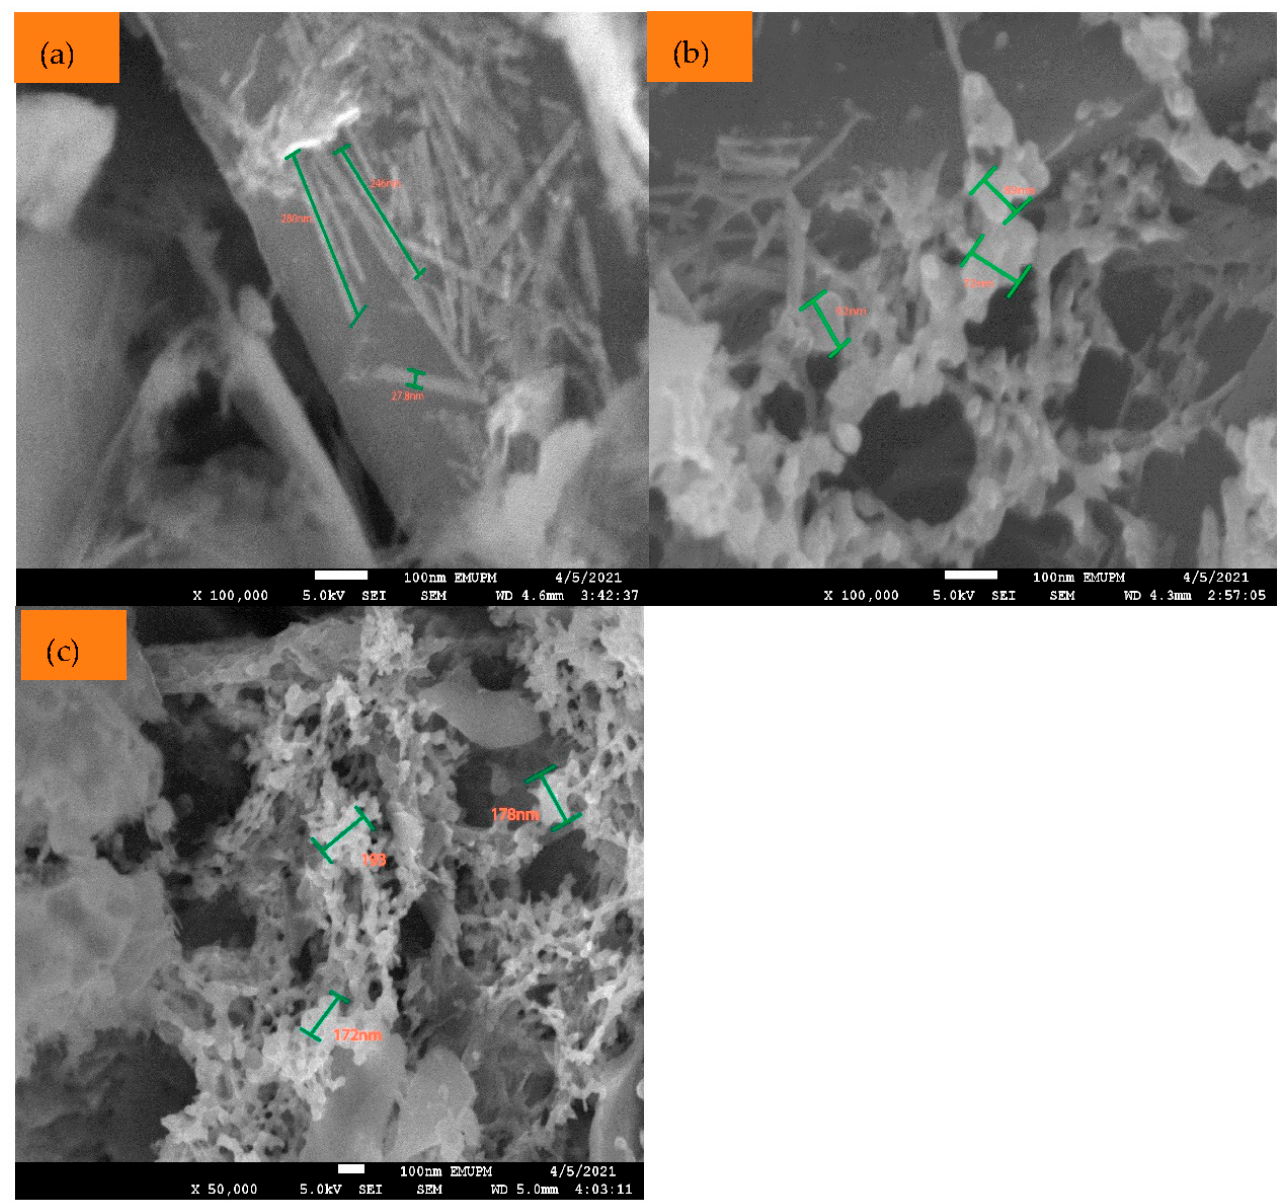
Figure 1. Representative FESEM images of samples. ( a ) Mn (0.5%) -Mo (0.1%) /AC, ( b ) Mn (0.5%) -Mo (0.5%) /AC and ( c ) Mn (0.5%) -Mo (1%) /AC.